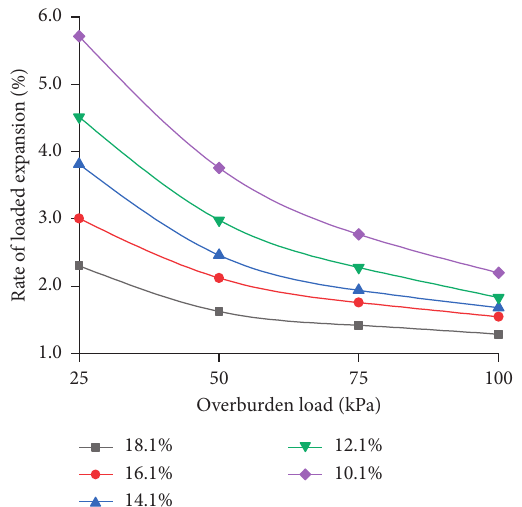
Figure 15: Curve of the loaded expansion rate of remolded